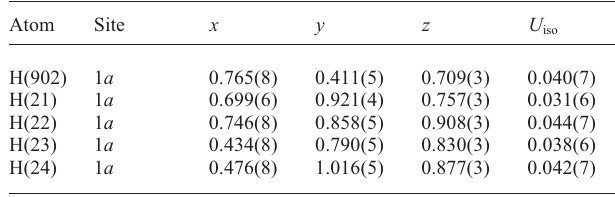
Table 2. Atomic coordinates and displacement parameters (in Å 2 ) .